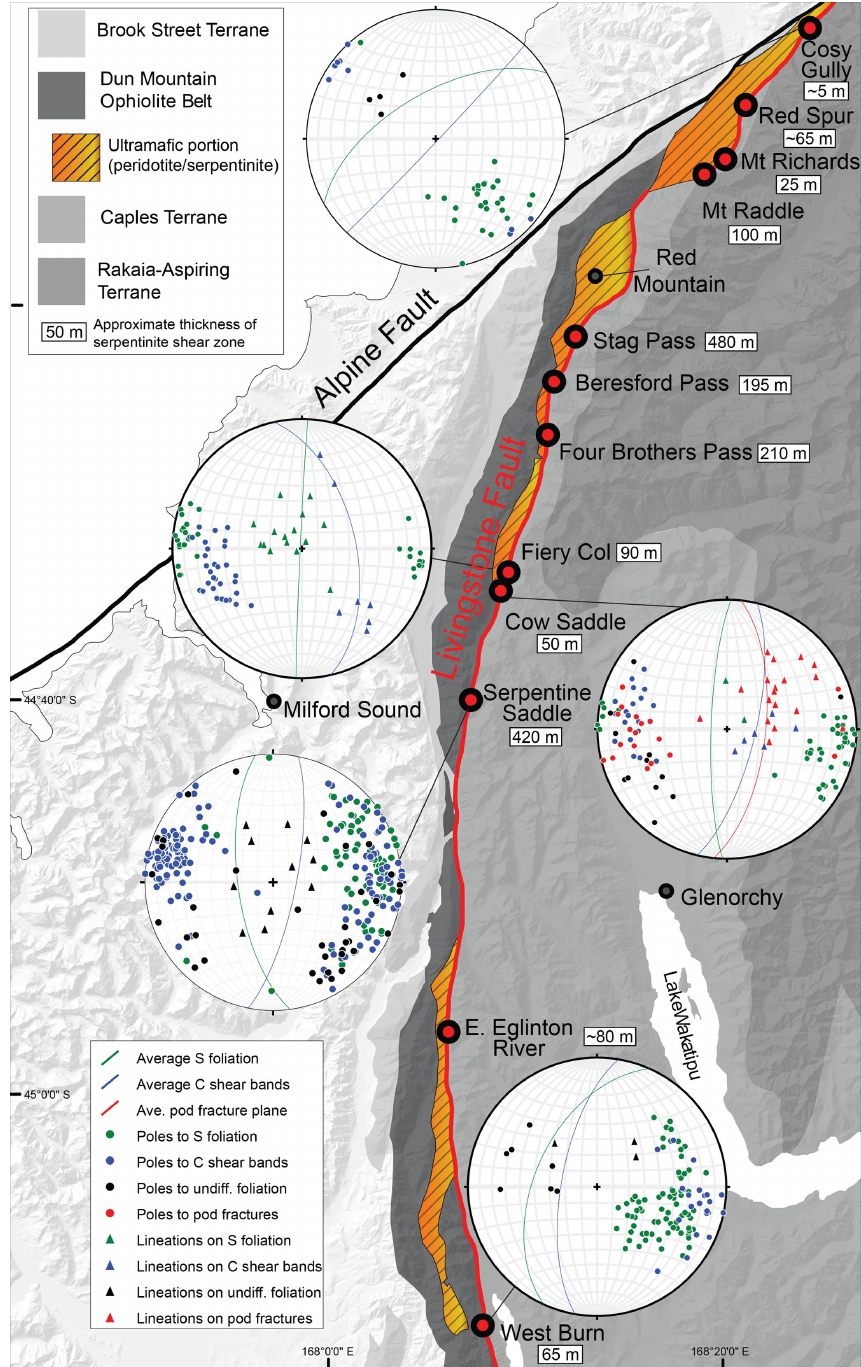
Figure 2. Simplified geological map of the Livingstone Fault with 11 study sites marked, from Cosy Gully in the north to West Burn in the south. The approximate thickness of the serpentinite shear zone based on field observations is shown at each locality. Stereonets (all lower hemisphere, equal area) represent measurements of the main shear zone fabrics, including undifferentiated scaly foliations, S–C fabrics where present and lineations. At Cow Saddle, additional data are provided for the orientations of brittle faults and associated lineations that cut through pods of massive serpentinite. Stereonets produced using Stereonet v10.1.6 (Allmendinger et al.,